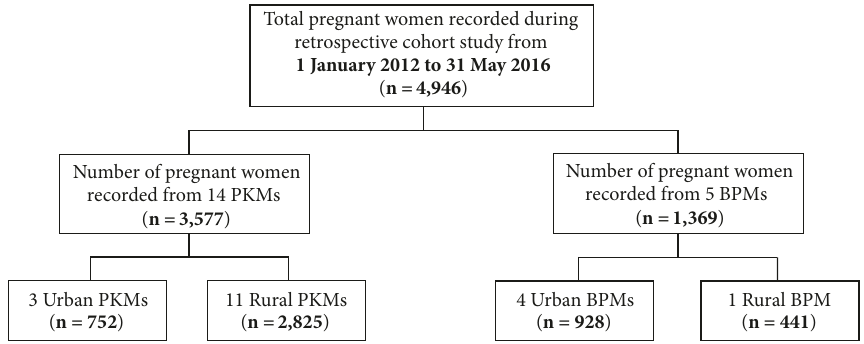
Figure 1: Description of retrospective